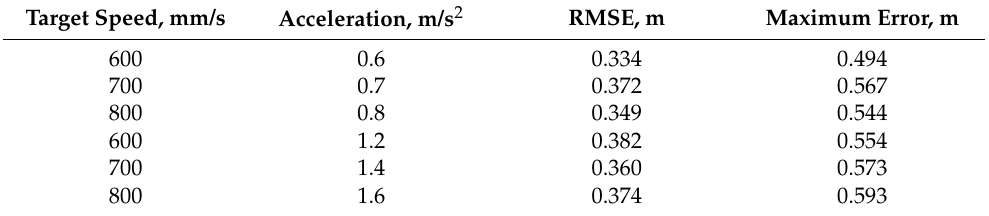
Table 4. The maximum error and RMSE on the z -axis under different dynamic testing